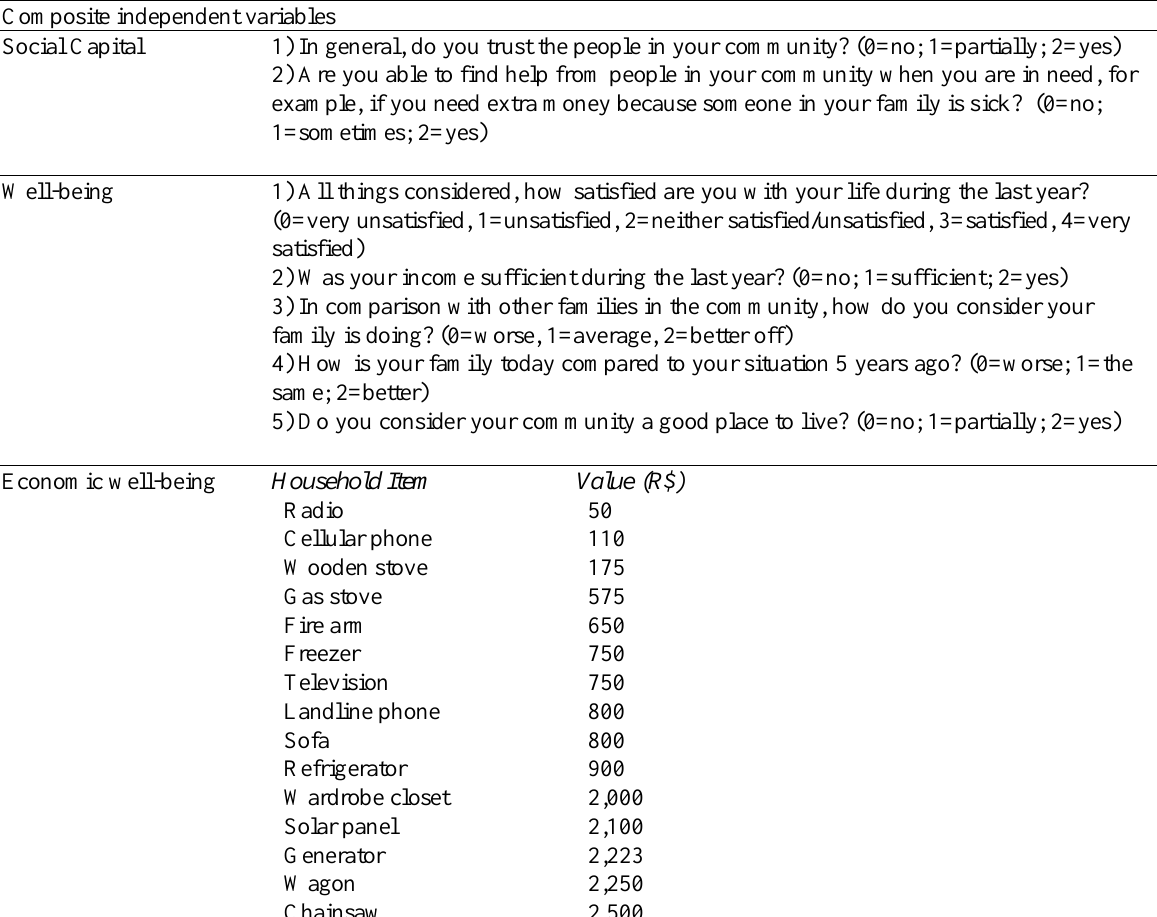
Table A2.1. Questionnaire items used to create composite independent variables used in the household-level logistic regression model development regarding participation in a logging project in the Chico Mendes Extractive Reserve, Brazil, 2014.